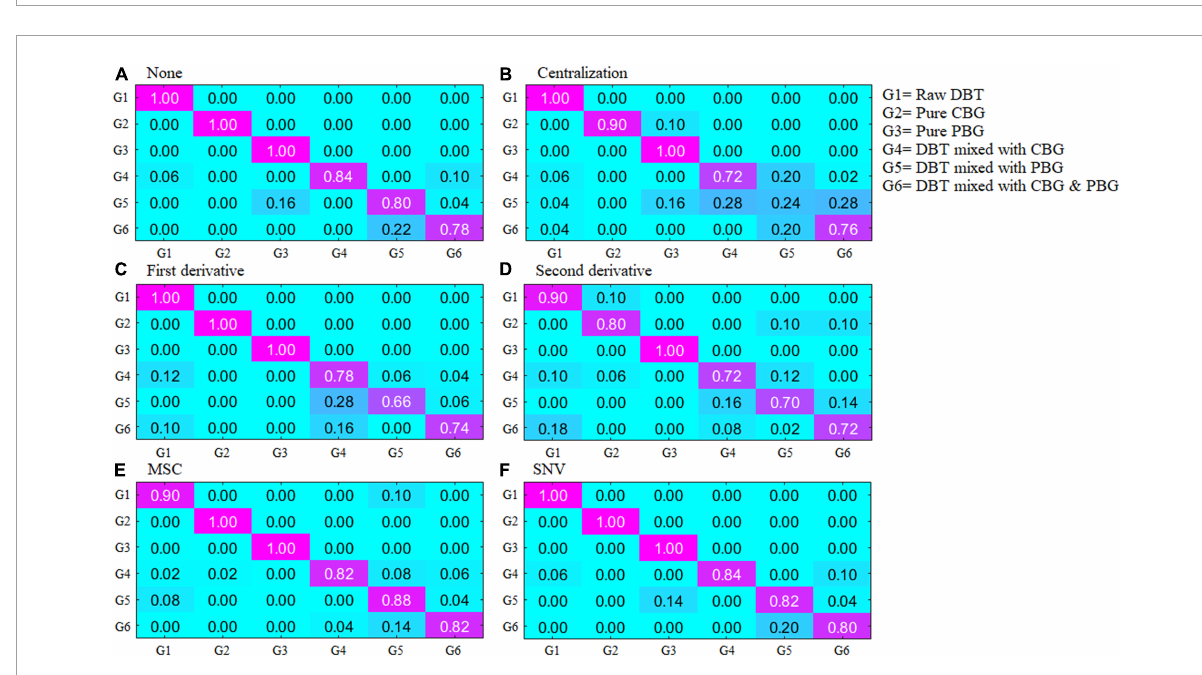
FIGURE3 The confusion matrixes of the training set of the Fisher LDA. DBT, Duck blood tofu; CBG, cow blood-based gel; PBG, pig blood